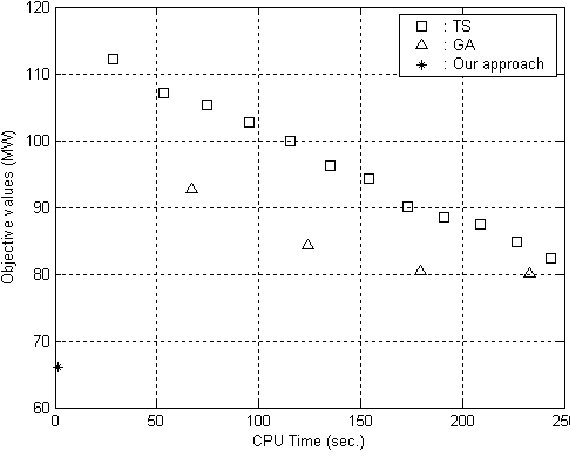
Figure 5. The progressions of the best-so-far objective values versus the consumed CPU time.